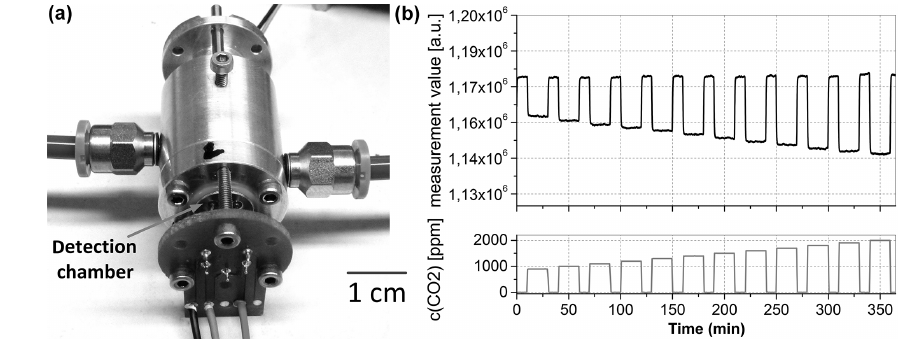
Figure 7. (a) Measurement set-up with detection chamber in a TO housing. b) Concentration measurement in the range from 900 to 2000ppmCO 2 in N 2 in steps of 100ppm.